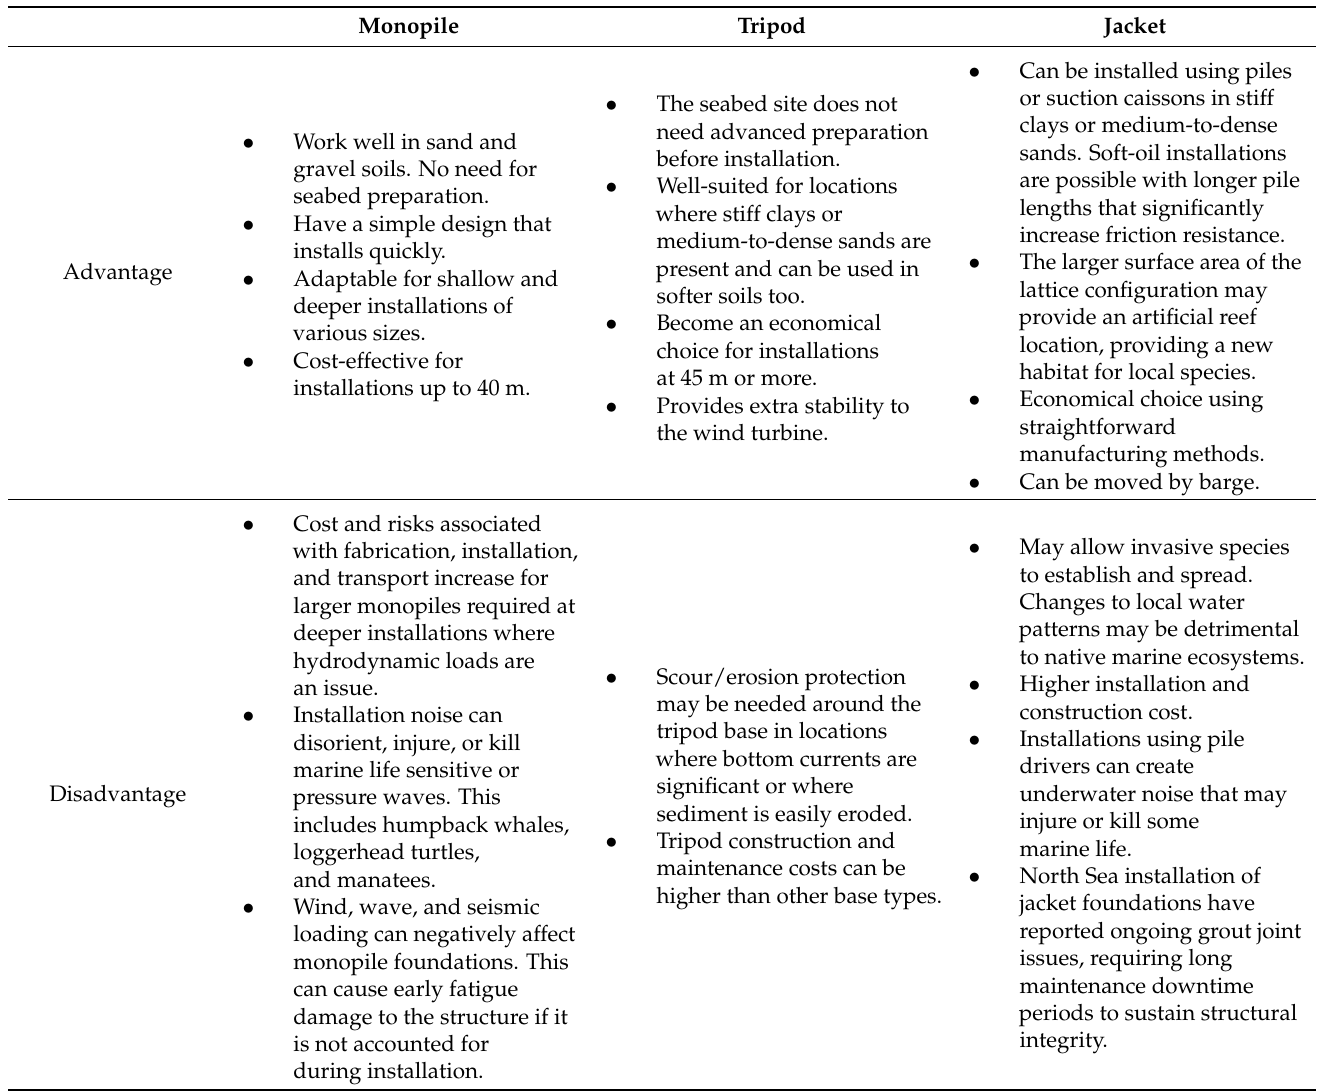
Table 1. Comparison of Substructures for Fixed Offshore Wind Turbines. Monopile Tripod